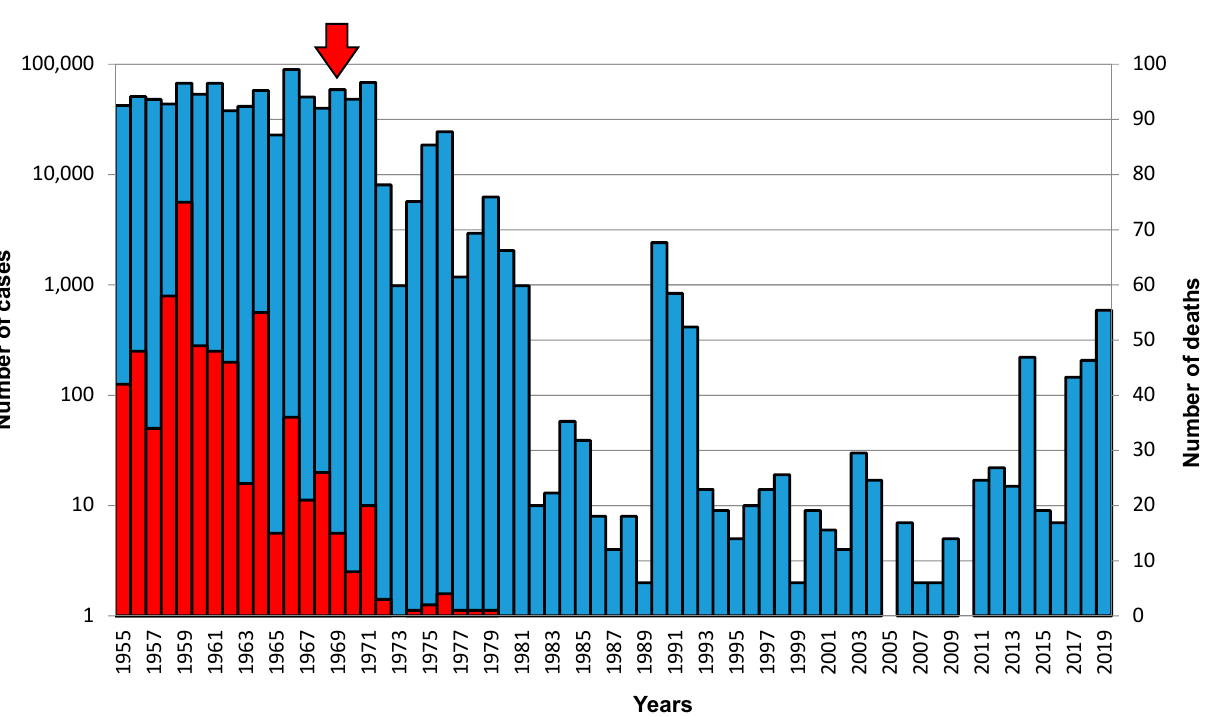
Figure 2. Cases of measles (blue, please note the logarithmic scale) and deaths caused by them (red) in the Czech Republic from 1955 to 2019 (Source: The National Institute of Public Health, Prague and [13]). Arrow indicates the beginning of the compulsory